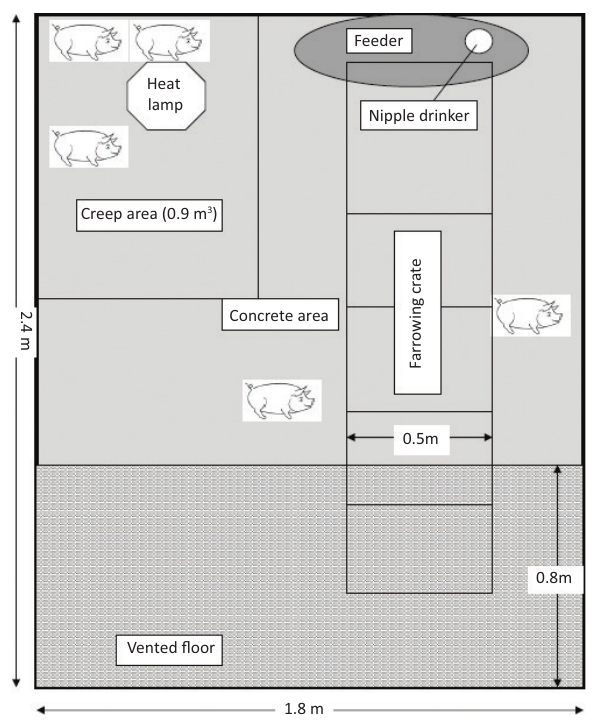
FIGURE 1: Standard farrowing pen with creep area, farrowing crate, concrete and vented